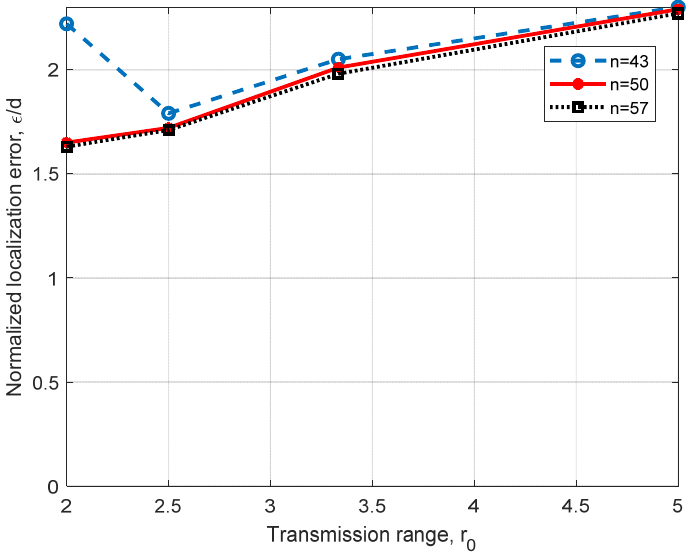
Figure 7. Error analysis for different numbers of nodes n in the network and different transmission Figure 8. Quadratic error CDF analysis for different transmission ranges, r 0 , and n = 43, using four ranges, r 0 , using four ANs in a 3D scenario, with d = 10 m. ANs in a 3D